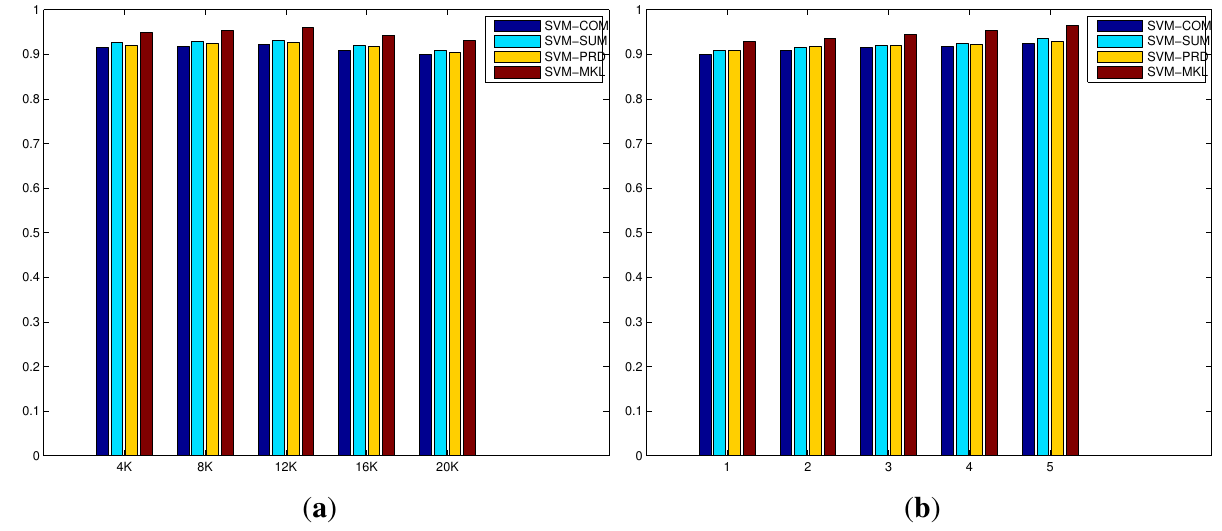
Figure 4. Performance comparisons on the original IXMAS dataset, of proposed methods, with respect to the size of BoWs (from 4 K to 20 K when the number of layers of mSDA is 5) and the number of layers of mSDA (from 1 to 5 when the size of BoWs is 4 K), in terms of average recognition rates. ( a ) The size of BoWs; ( b ) The number of layers of